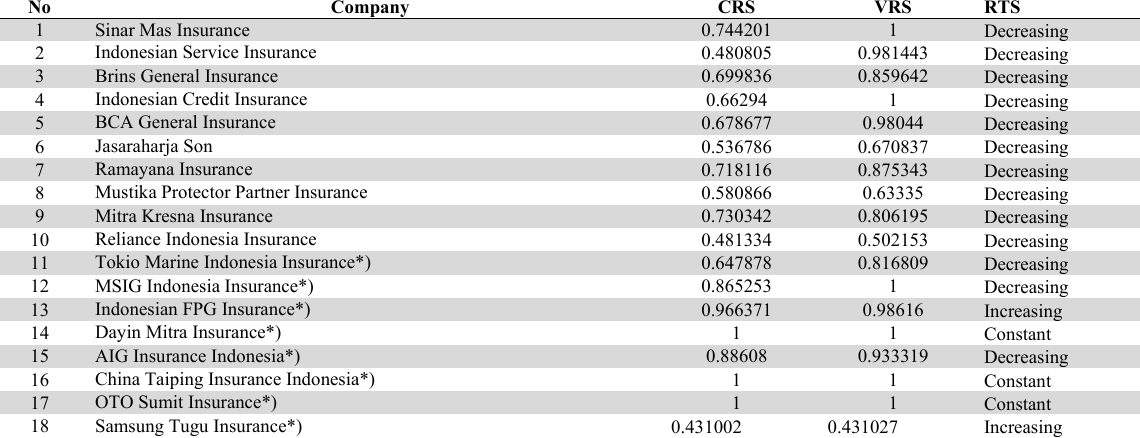
General Insurance Efficiency Level in 2017